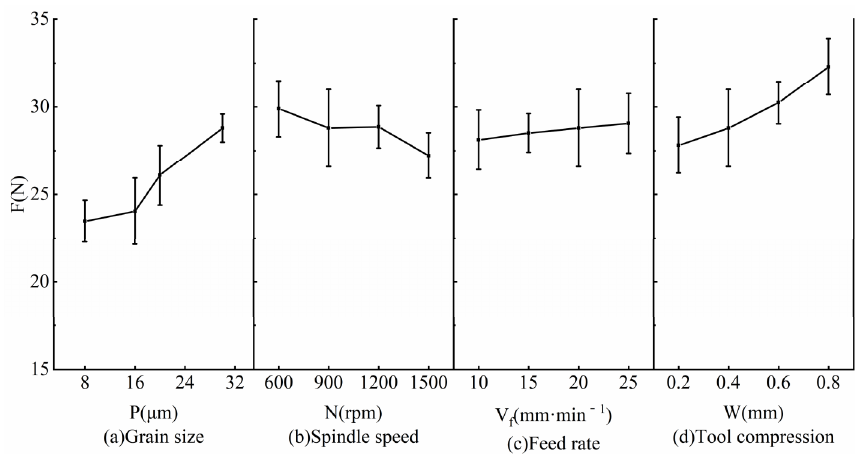
Figure 3. Influence of grinding parameters on grinding force: ( a ) Grain size, ( b ) Spindle speed, ( c ) Feed rate, ( d ) Tool compression.